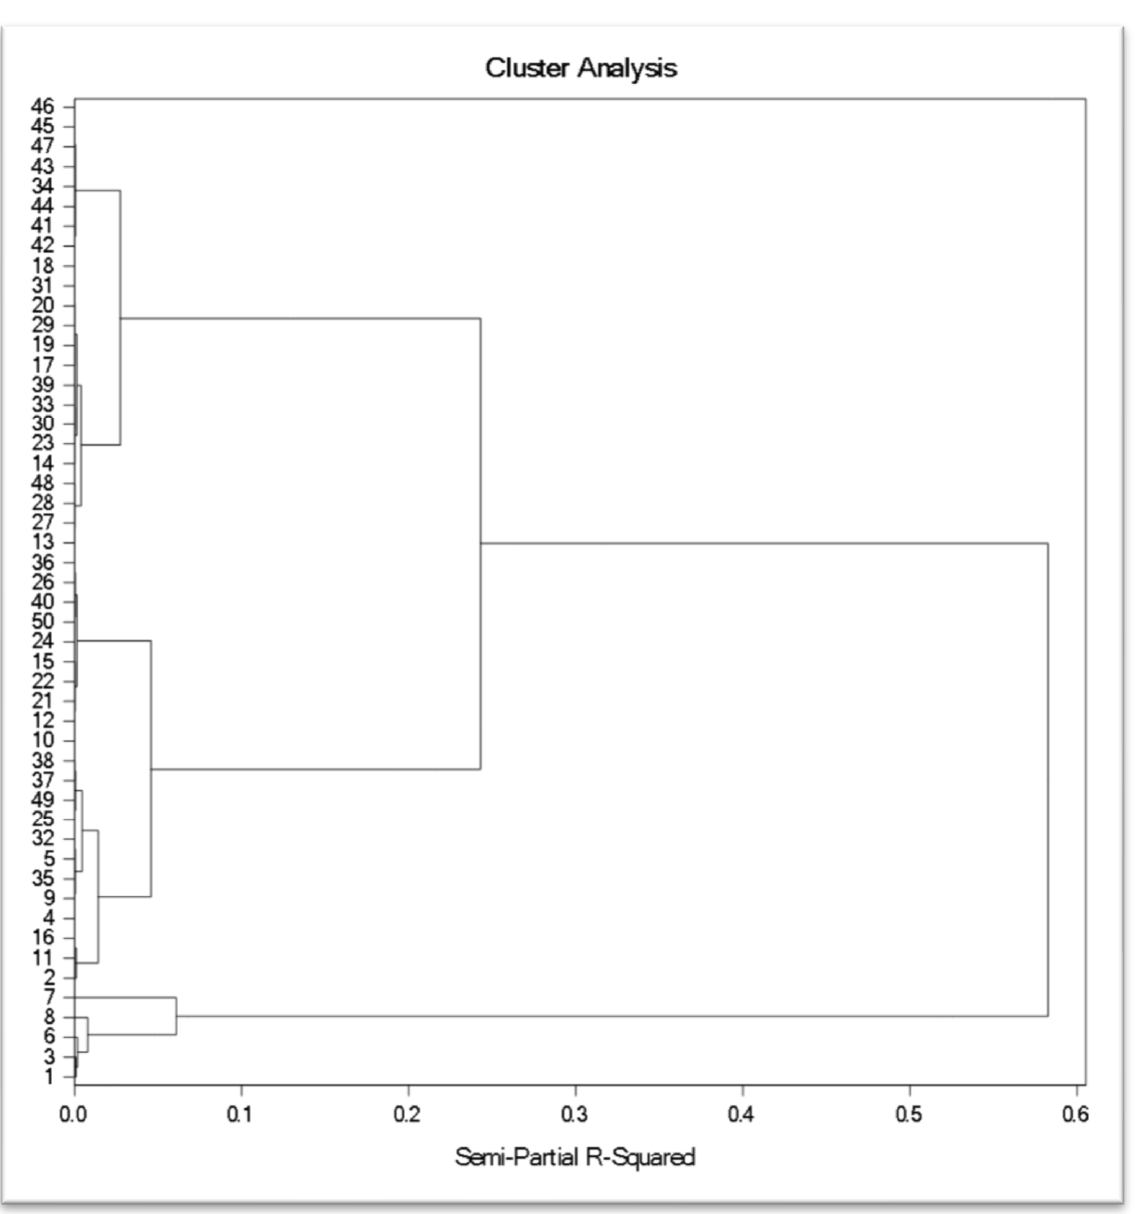
Figure 5. Cluster analysis of different rose varieties. 1: Pusa Arun, 2: Raktima, 3: Nehru Centenary,